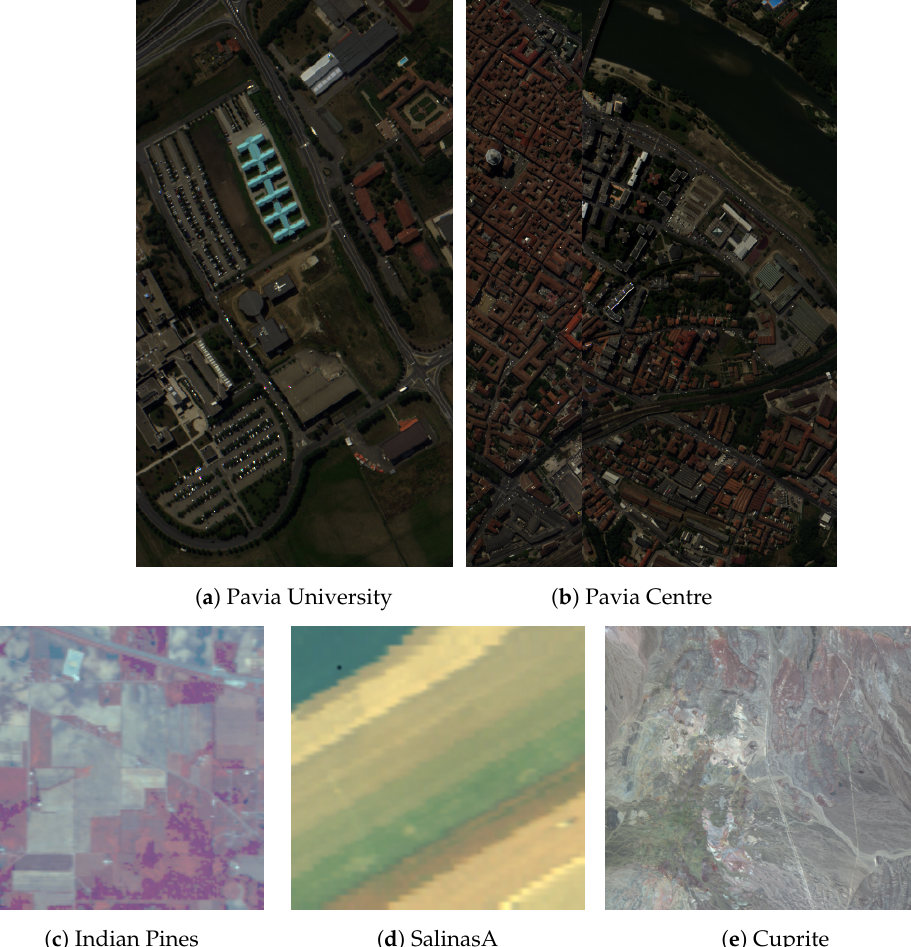
Figure 1. RGB representations of the five hyperspectral images used in our experiments. Top row: images acquired by the ROSIS-3 sensor; bottom row: images acquired by the AVIRIS